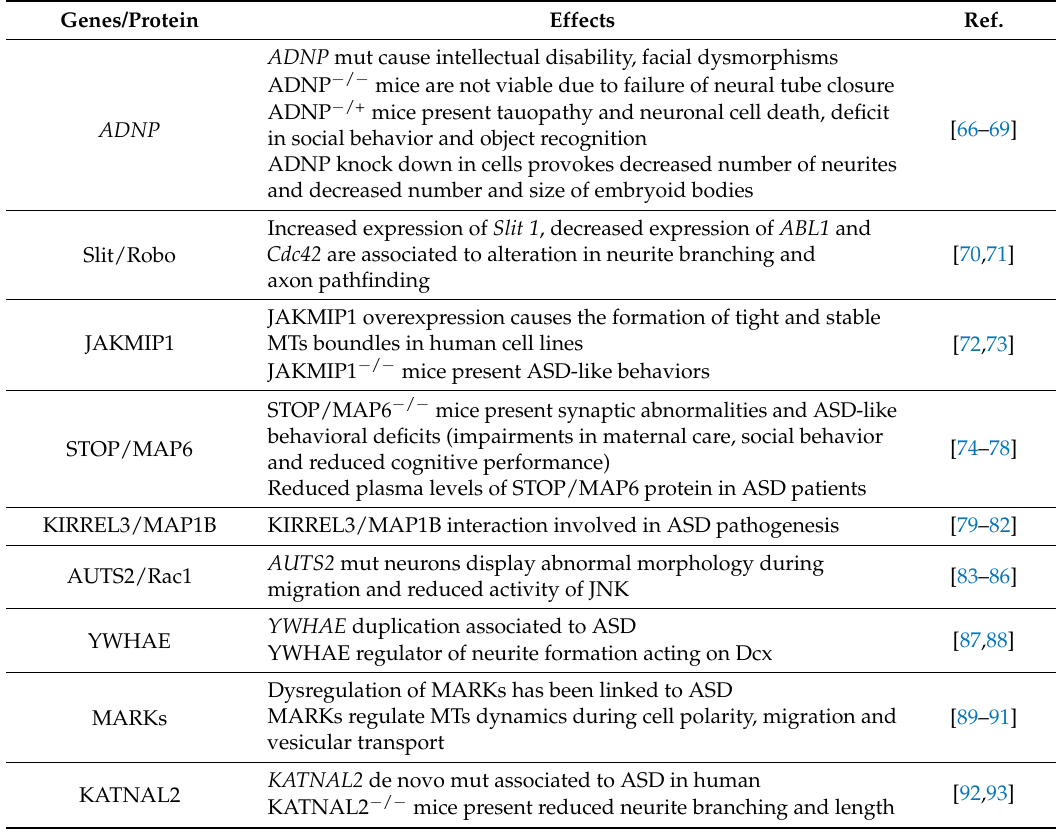
Table 1. MTs and MTs regulatory protein and gene alterations associated with Autism (ASD).